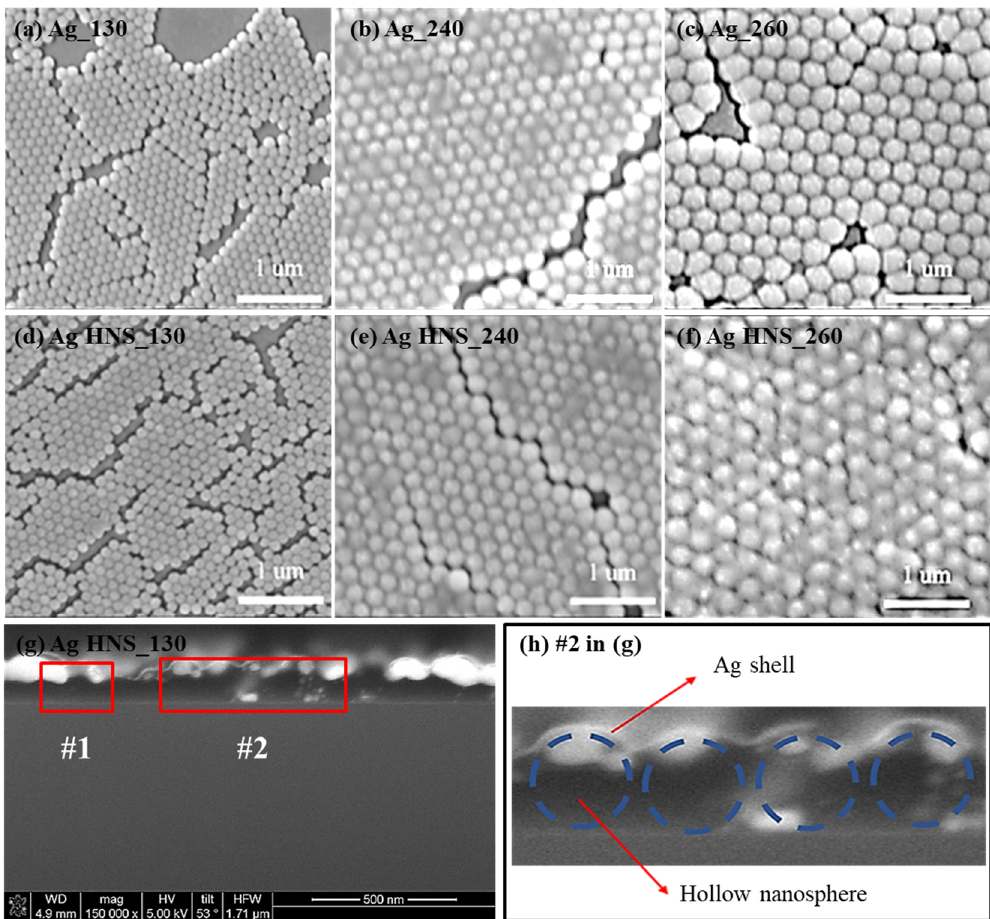
Figure 2. SEM images of Ag on PS_Bs with the diameters of 130, 240, and 260 nm and heat-treated Ag HNS were respectively shown: ( a ) Ag_130, ( b ) _240, ( c ) _260, ( d ) Ag HNS_130, ( e ) _240, and ( f ) _260. The magnification is 25,000×. To examine the cross section of (g) Ag HNSs_130, the sample was cut by FIB/SEM. A magnification of 100,000× was shown. The HNS structures between Si substrate and Ag shell were cut and shown (boxed in red and marked as #1) and ( h ) a closer examination of ( g ) with that of 150,000× (blue circles marked as #2).